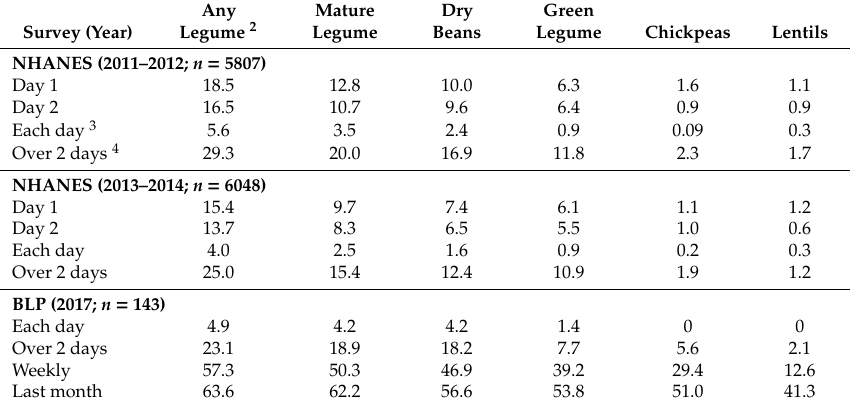
Table 2. Consumption frequency of legume types in US adults: National Health and Nutrition Examination Survey (NHANES) and Beans, Lentils, Peas Nutrition Education Online Parent Survey (BLP) 1